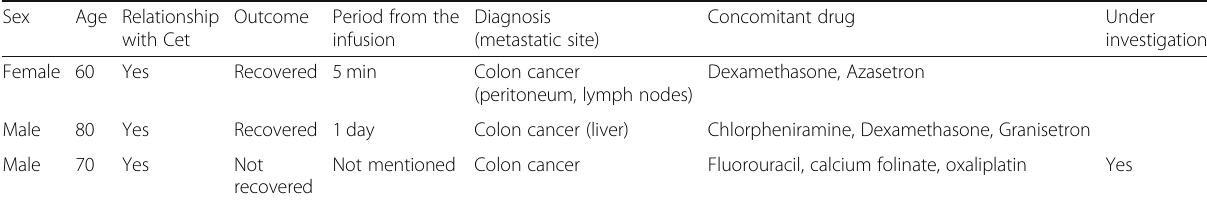
Table 4 Details of cases of loss of consciousness on the manufacturer ’ s reports of adverse events